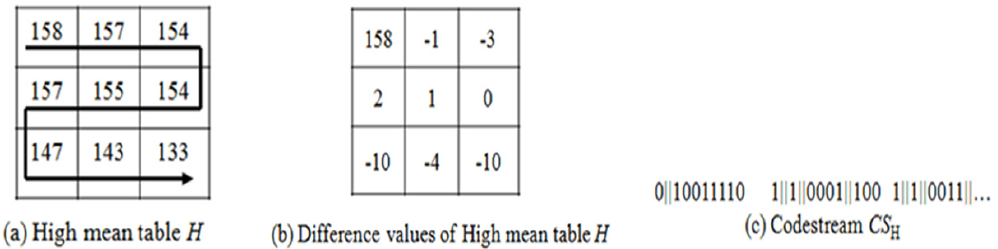
Figure 6. Example of the embedding algorithm for high mean table: ( a ) high mean table H ; ( b ) difference value of high mean table H ; ( c ) codestream CS H .